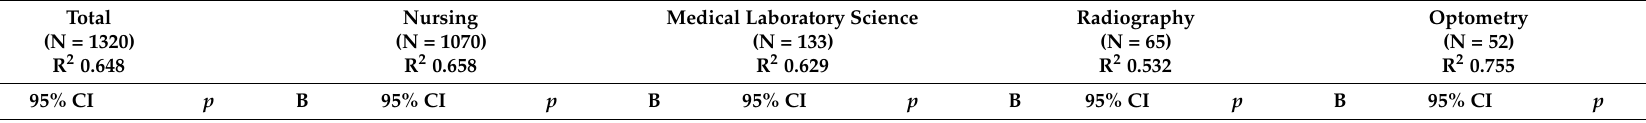
Table 3. General linear regressions to determine the predictors of resilience in all students and four student groups (N =